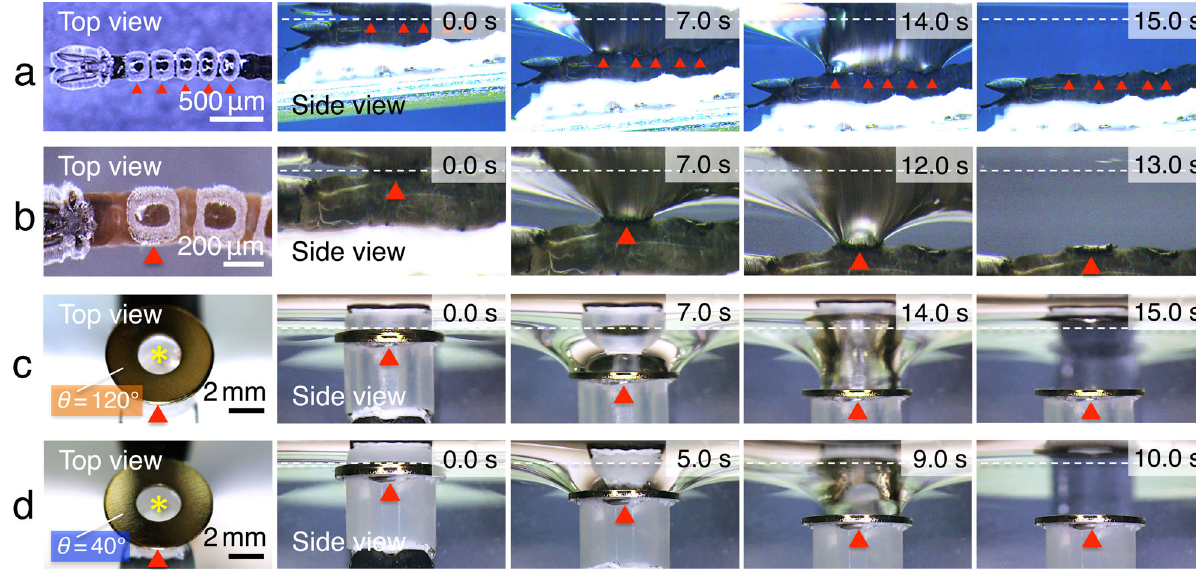
Fig 5 Pull-off experiments from the water surface. a , b Top- and side-view video images of the larvae acquired during the experiments in which the crowns were pulled underneath the water surface. c , d Top- and side-view video images of experiments involving the pulling of arti fi cial substrates perpendicularly from underneath the water surface. Note that the central regions of these substrates (single asterisk) contained water. Overlaid white dotted lines indicate the free water surface in a – d . Red arrowheads indicate the positions of the crowns in a and b and the arti fi cial substrates in c and d , respectively.